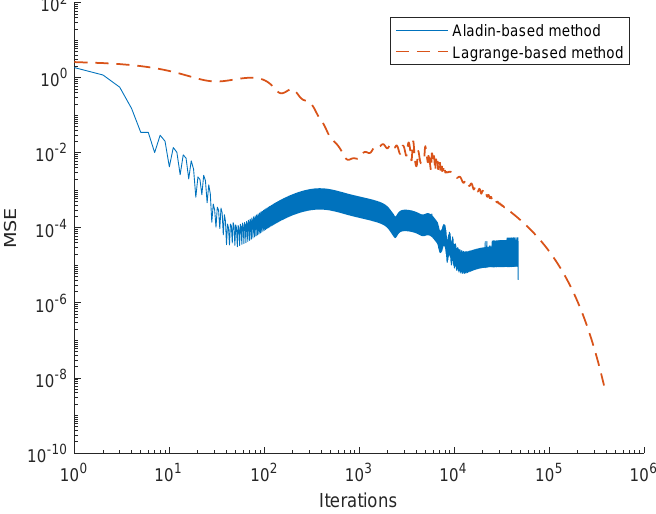
Figure 9. Convergence of the cost function according to its